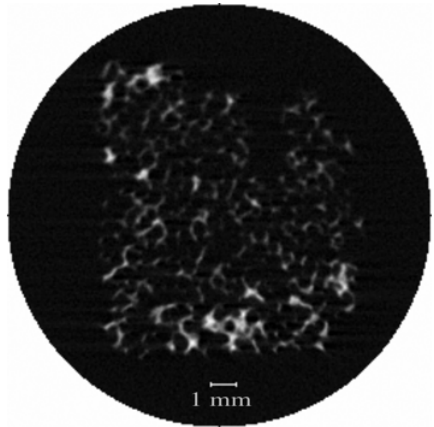
Figure 2. Ceramic foam samples of 60 ppi, 75 ppi and 90 ppi (from left to right).